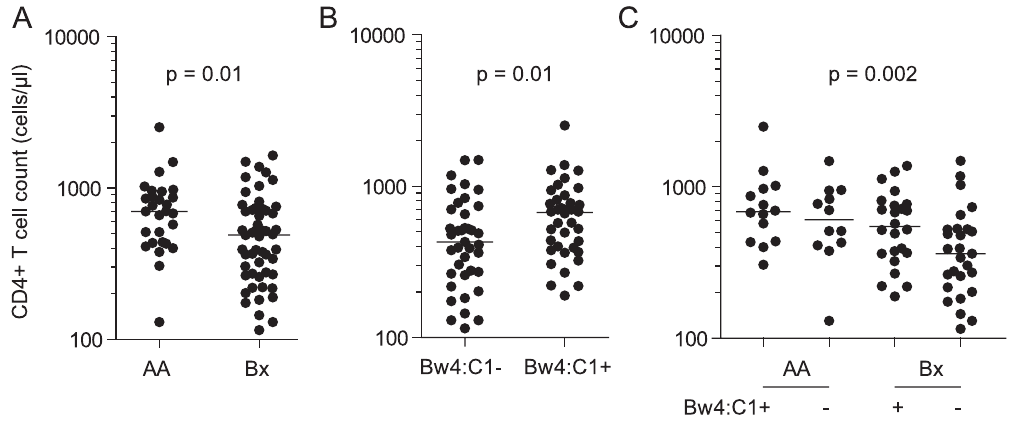
Figure 1. Effect of KIR and HLA genotypes on the CD4 + T cell count of HIV-1 infected subjects. (A) Effect of AA versus Bx genotype (n=81). (B) Combined effect of inhibitory KIR ligand genes Bw4 and C1 (n=73). Bw4:C1 denotes the simultaneous occurrence of Bw4 and C1. (C) Combined effect of Bx and Bw4:C1 genotypes (n=73). P values represent the statistical significance of the linear regression models using log-transformed CD4 + T cell counts as the dependent variable. Horizontal lines represent median values.